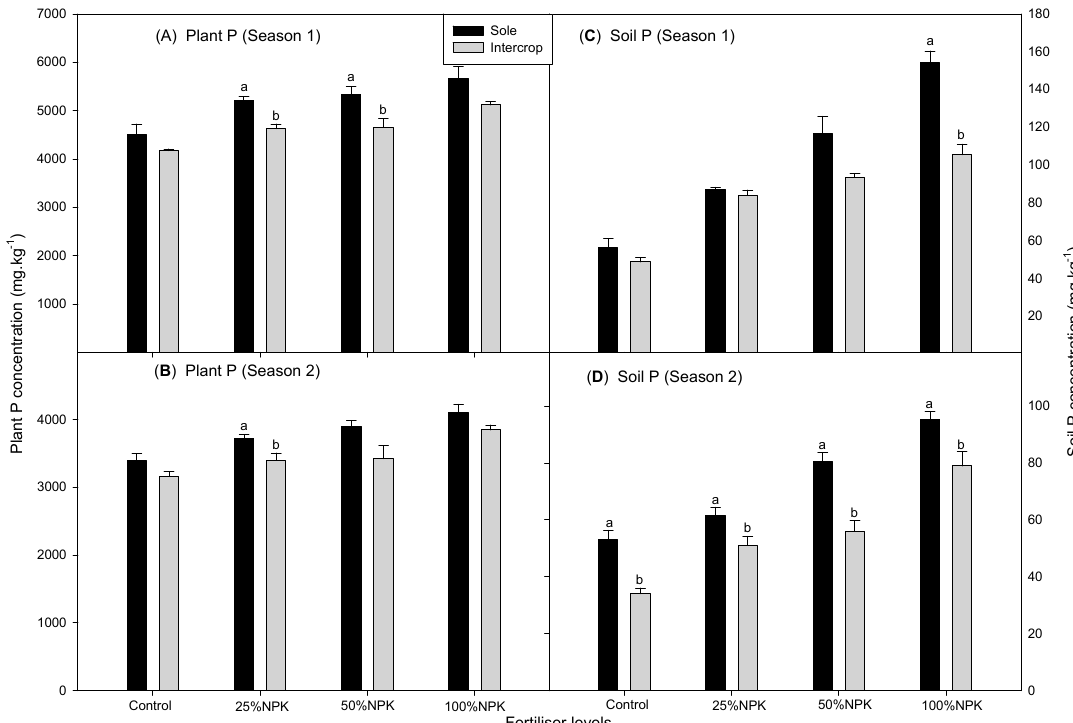
Figure 5. Two-way analysis showing the e ff ects on ( A , B ) plant and ( C , D ) soil P concentration on Figure 5. Two ‐ way analysis showing the effects on ( A , B ) plant and ( C , D ) soil P concentration on rhizosphere rhizosphere of amaranth at four NPK levels in 2014 / 15 and 2015 / 16 seasons. Each bar represents the of amaranth at four NPK levels in 2014/15 and 2015/16 seasons. Each bar represents the mean ± SE (n = 4). mean ± SE (n = 4). Di ff erent letters in each fertilizer treatment shows significant di ff erences at p ≤ 0.05 Different letters in each fertilizer treatment shows significant differences at p ≤ 0.05 in sole or intercropping. in sole or